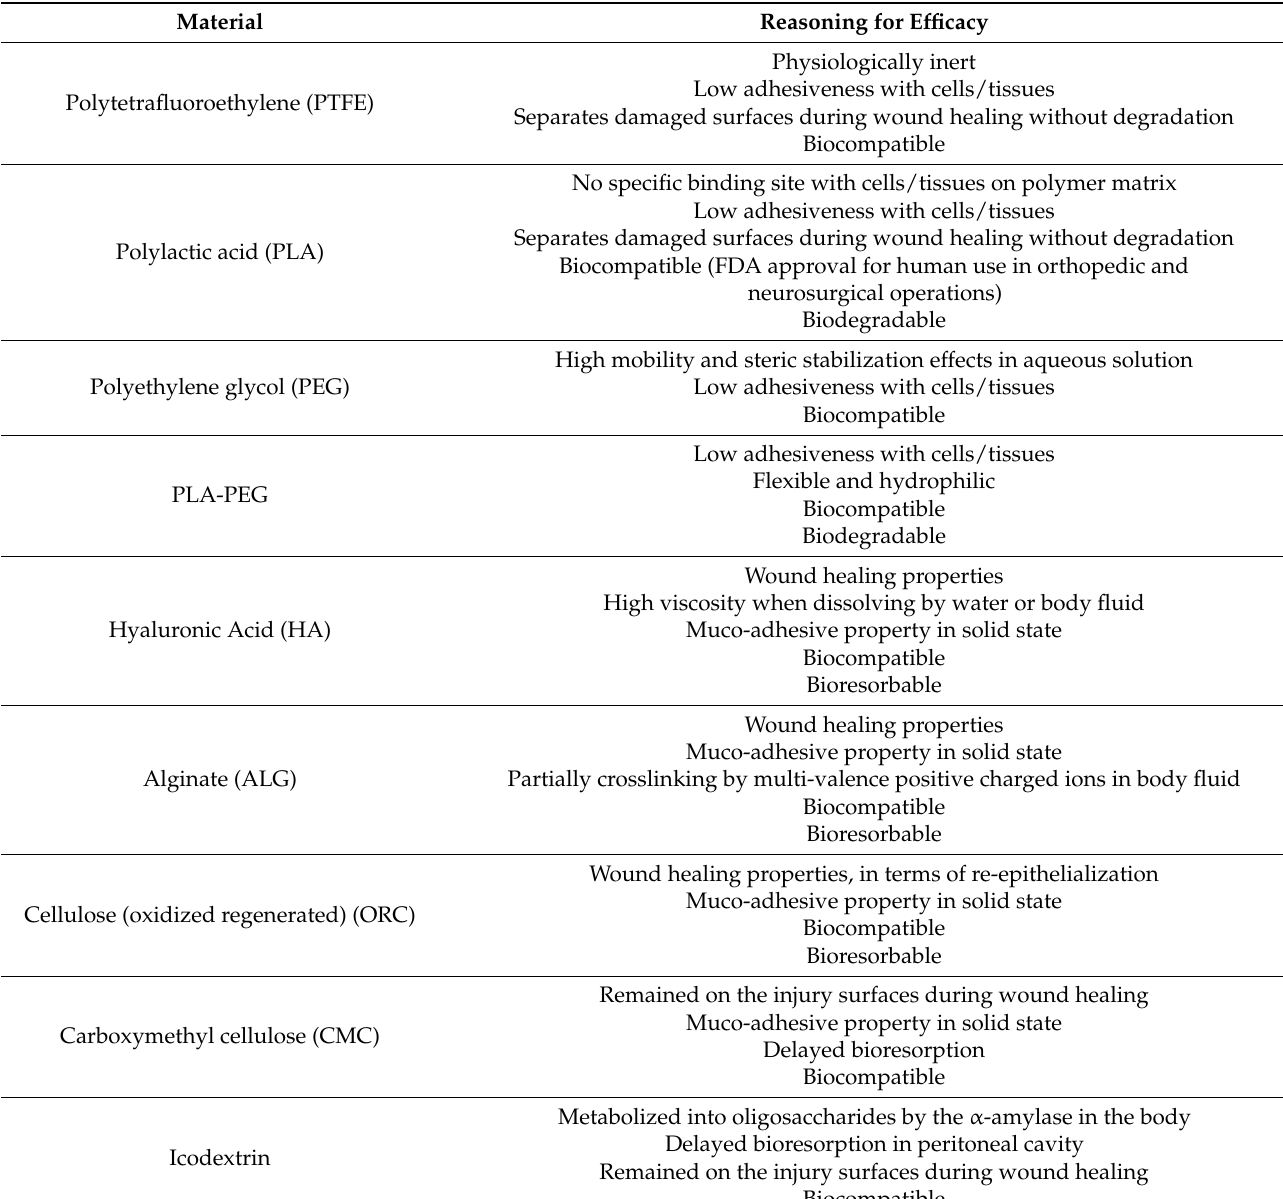
Table 2. Materials commonly used in adhesion prevention and a brief description of possible reasons for efficacy in adhesion prevention. Adapted from